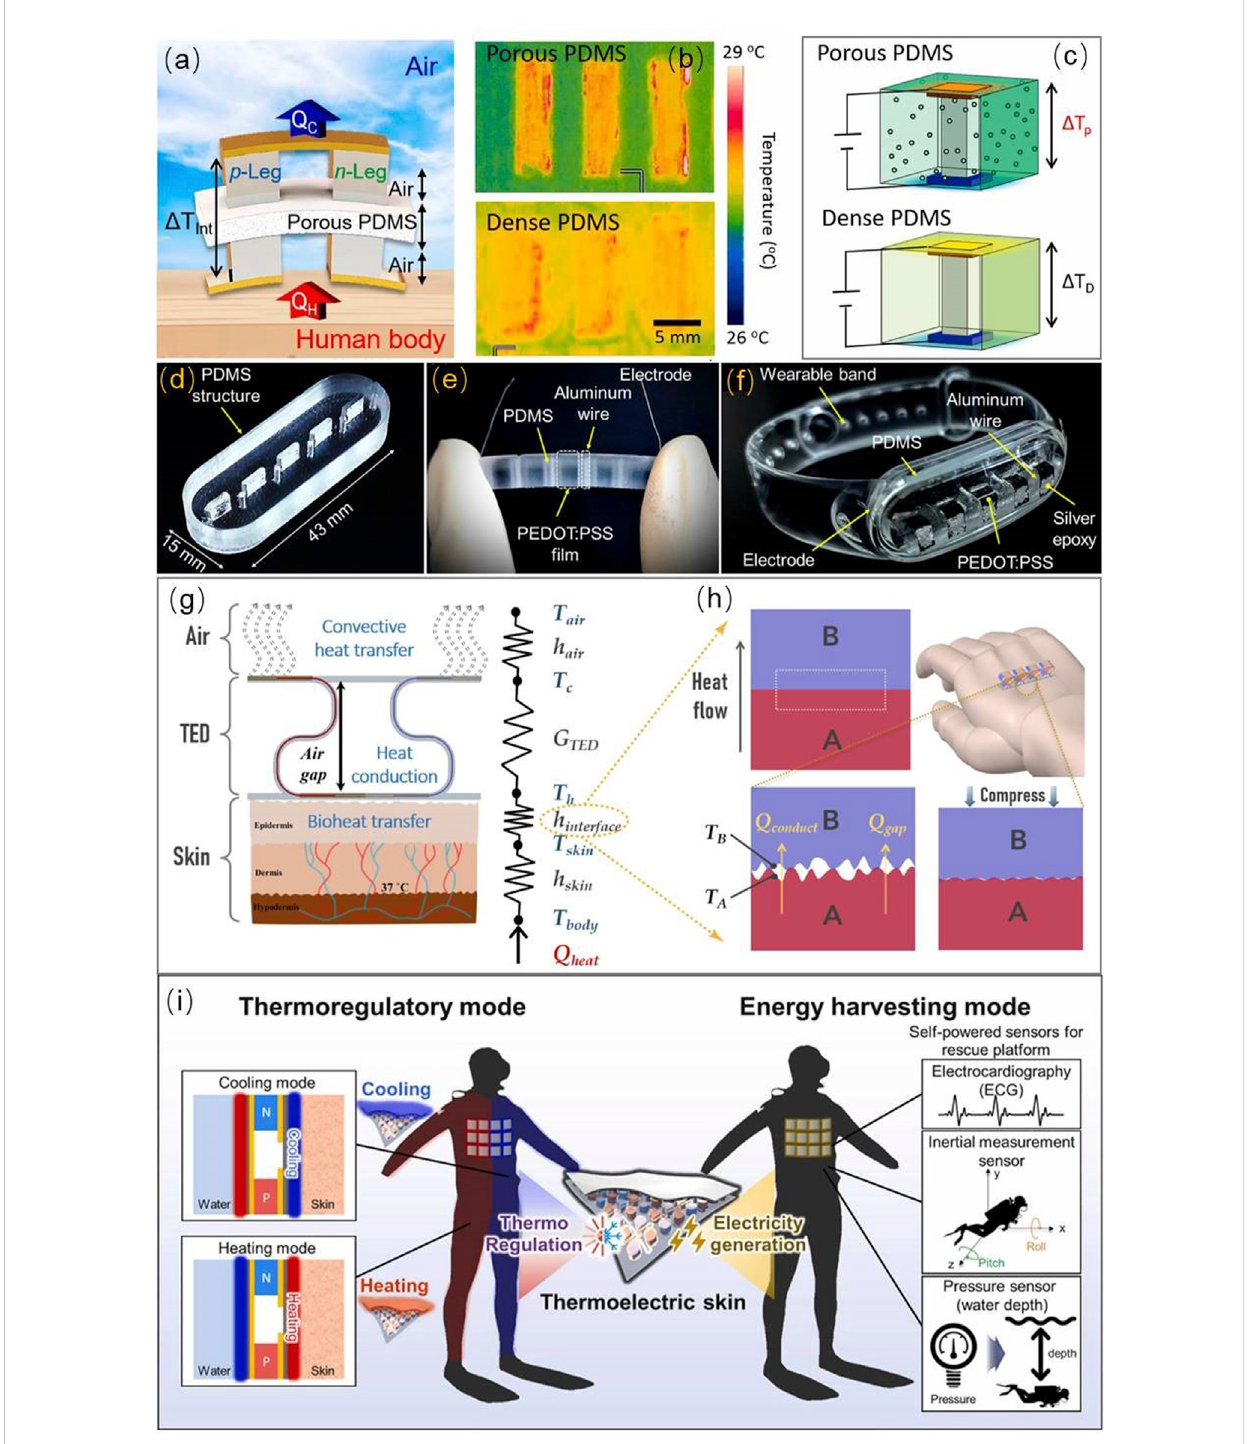
FIGURE 6 (A) Schematic diagram of a partially fi lled TEM. (B) Temperature response of the hot-side surfaces of pP TEM and dP TEM when direct current was used. (C) Schematics of the TEM con fi gurations during the direct current experiments (Jung et al., 2021). (D) Optical photo of the fabricated PDMS structure, (E) side view of the wearable thermoelectric generator, and (F) a wearable band integrating the fabricated thermoelectric generator (Hasan etal., 2022). (G) Schematicdiagram of thecompletethermal process for awearable S-TED. (H) Interface thermal resistance analysis(Lvet al., 2021). (I) Schematic illustration of dual modes (energy harvesting mode/thermoregulatory mode) that the TES switch between (Jung et al.,